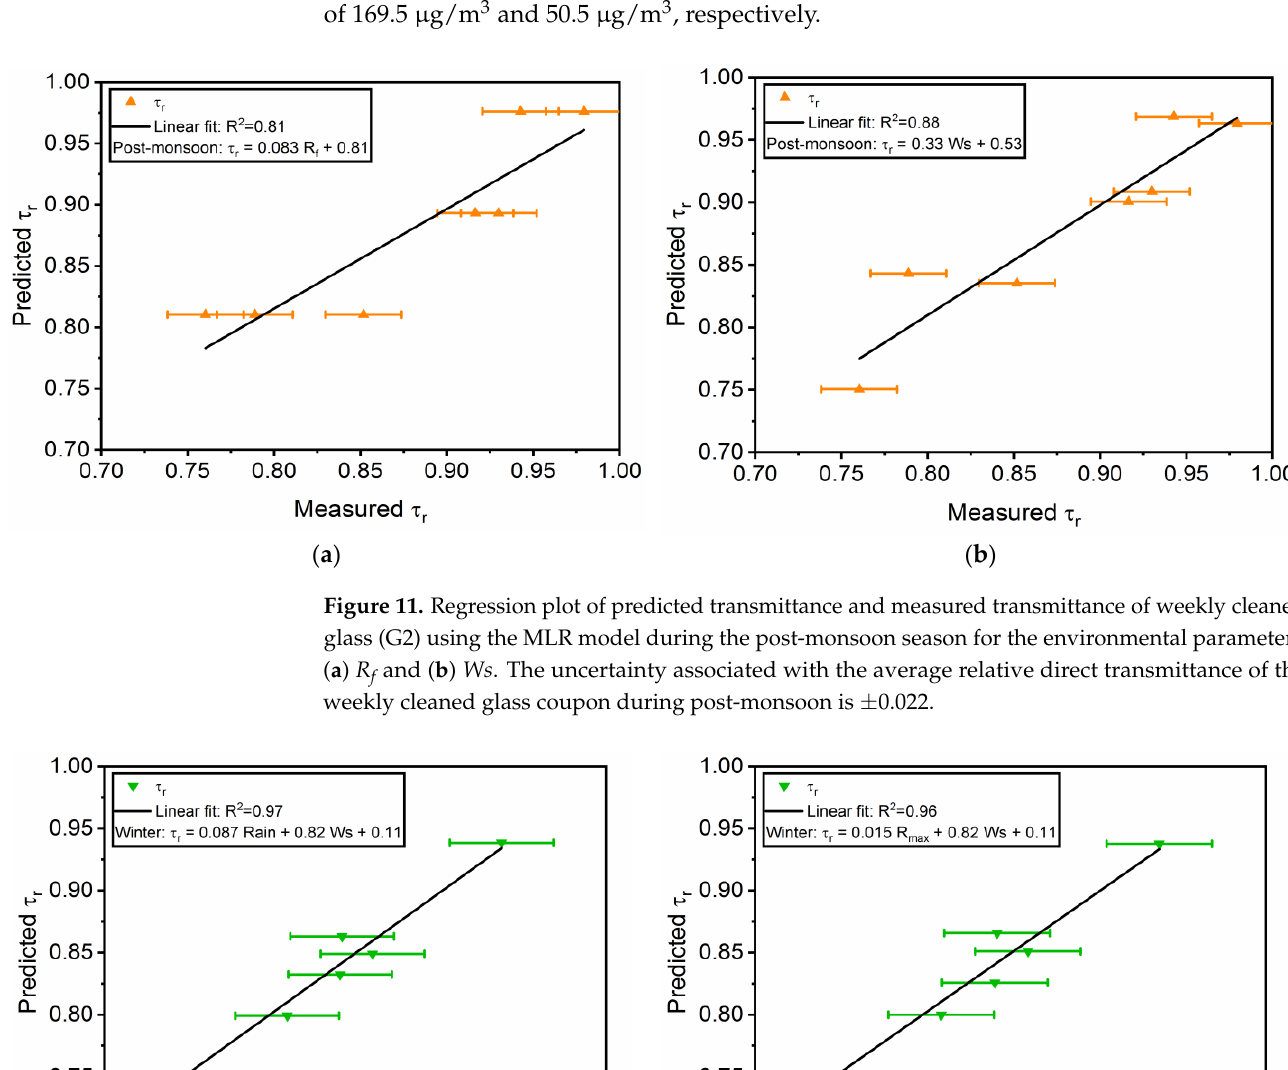
Figure 13. Regression plot of predicted transmittance and measured transmittance of weekly cleaned glass (G2) using the MLR model for a year. The uncertainty associated with the average relative direct transmittance of the weekly cleaned glass coupon is ±0.02. The solid line represents the linear fit and the dashed line represents an exponential fit with an offset to guide the eye. For the values of parameters of the linear and exponential fits refer to Tables S8 and S9. 3.5. Cleaning Cycle and Seasonal Analysis As part of the comprehensive analysis outlined in Figure 1, the seasonal τ loss of the glass coupons G2, G3, and G4 during various seasons over the year is shown in Figure 14. These average values are also presented in Table 1. The annual average transmittance loss due to soiling was 7.9%, 10%, and 12.9% for weekly (G2), monthly (G3), and never (G4) cleaning cycles, respectively. As discussed in the earlier section for the statistical t -test analysis, recommendations are made regarding the cleaning cycle on a seasonal basis. In a location like Tezpur with high RH , a warm and wet monsoon season, and a dry winter, weekly cleaning can maintain a high weekly τ r above 80% during post-monsoon and win- ter seasons and monthly cleaning can maintain the weekly τ r above 90% during pre-mon- soon and SW monsoon seasons.